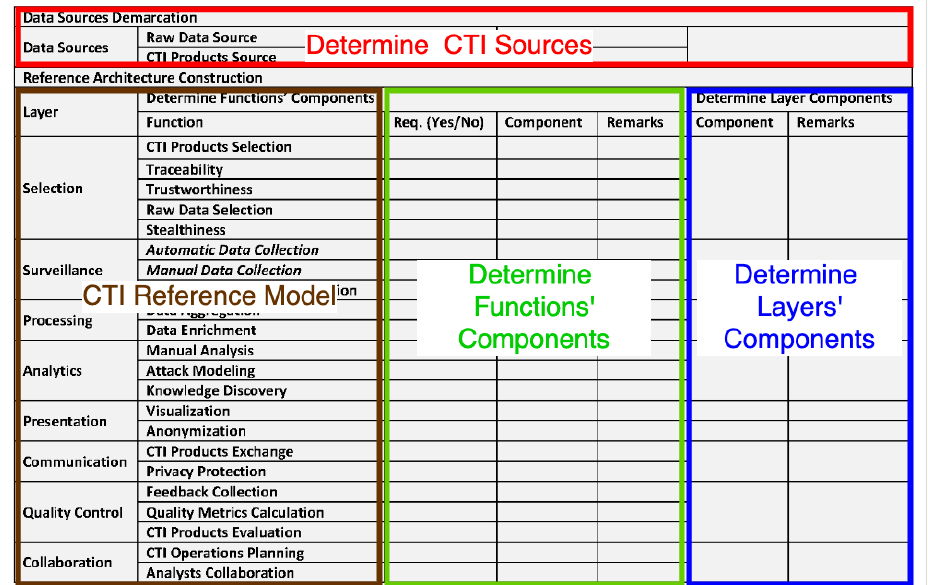
Figure 11. Matrix Structure used for the application of the CTI Reference Model.